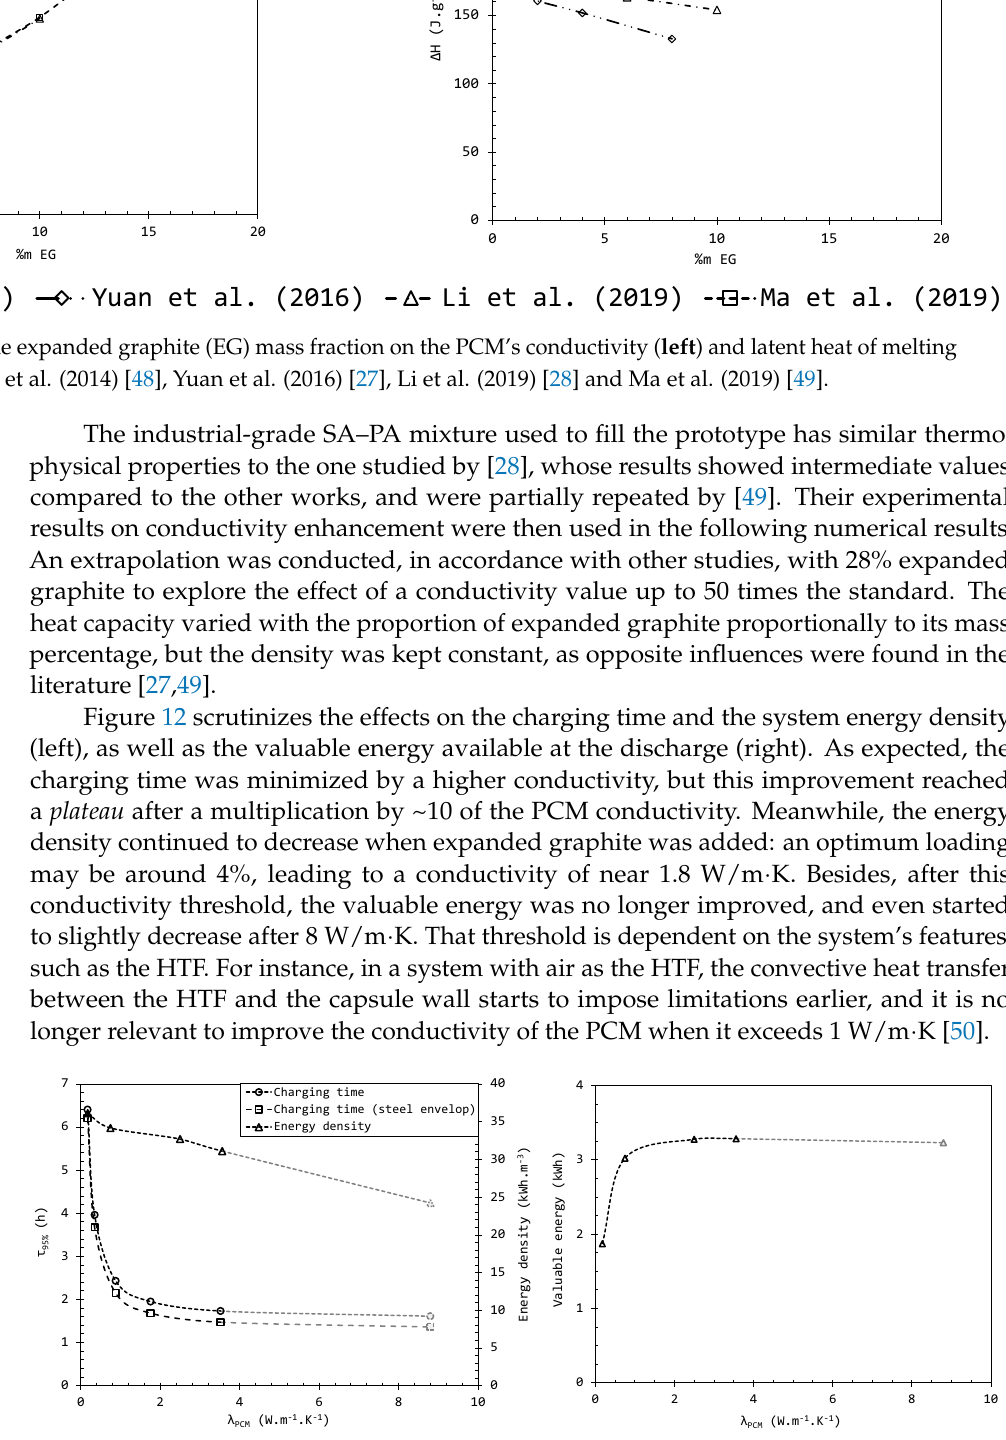
Figure 12. Charging time τ 95% , energy density and valuable discharge energy above 45 °C for different values of the PCM thermal conductivity.